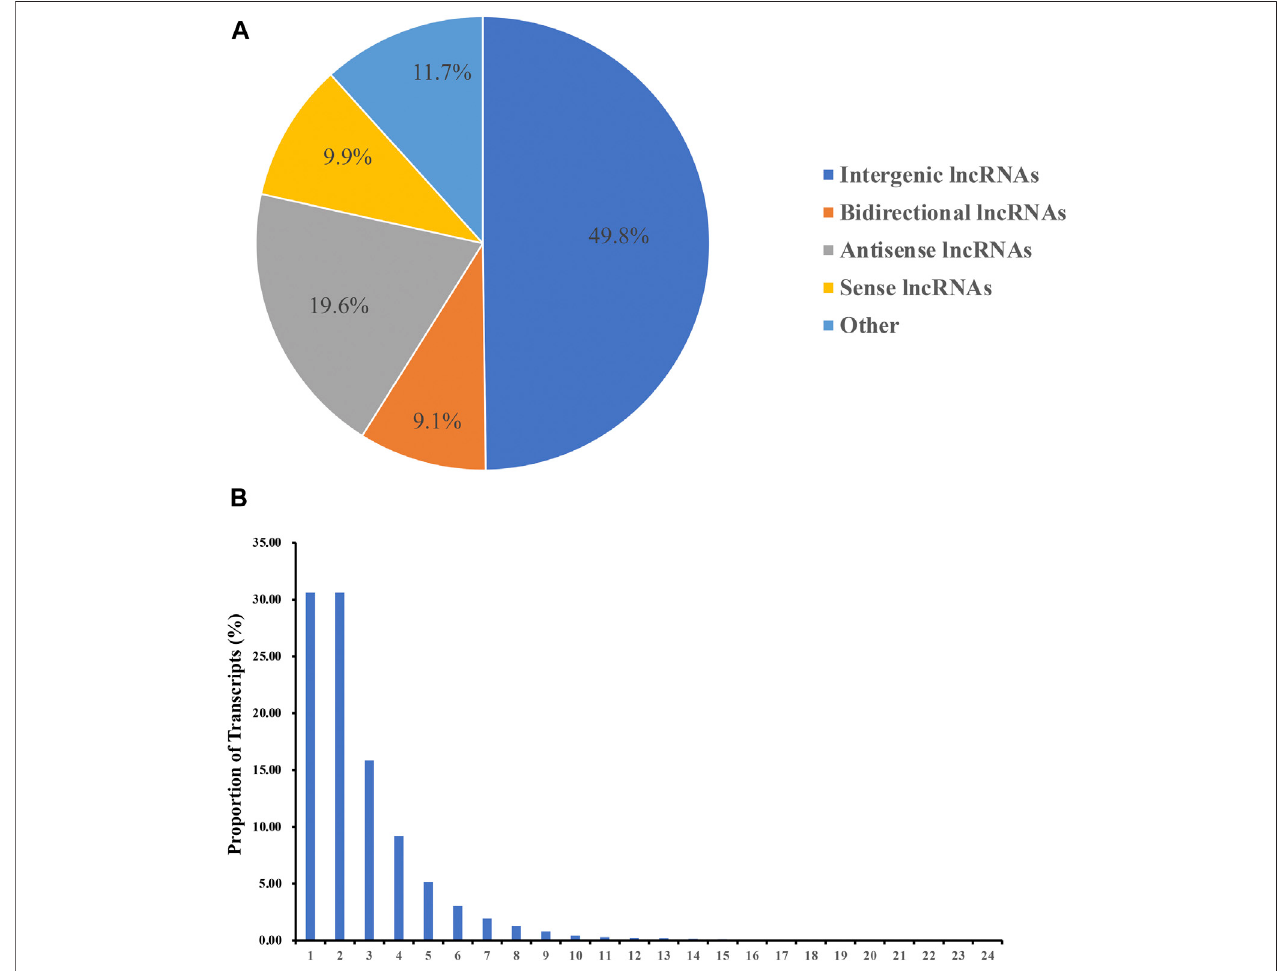
FIGURE 1 | Identi fi cation of lncRNAs. (A) Categories of the novel lncRNA transcripts. (B) Number of exons in the novel lncRNA transcripts.